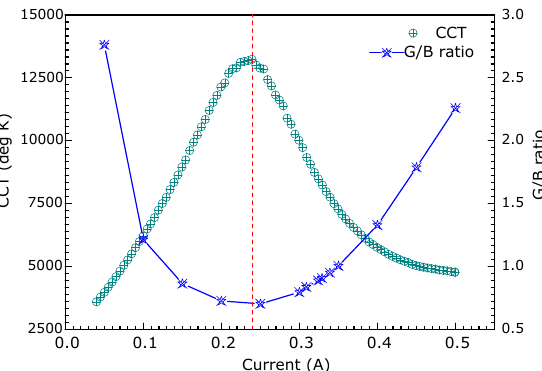
Figure 3. Green/Blue (G/B) ratio and corresponding correlated color temperature (CCT) tuning with variation of direct